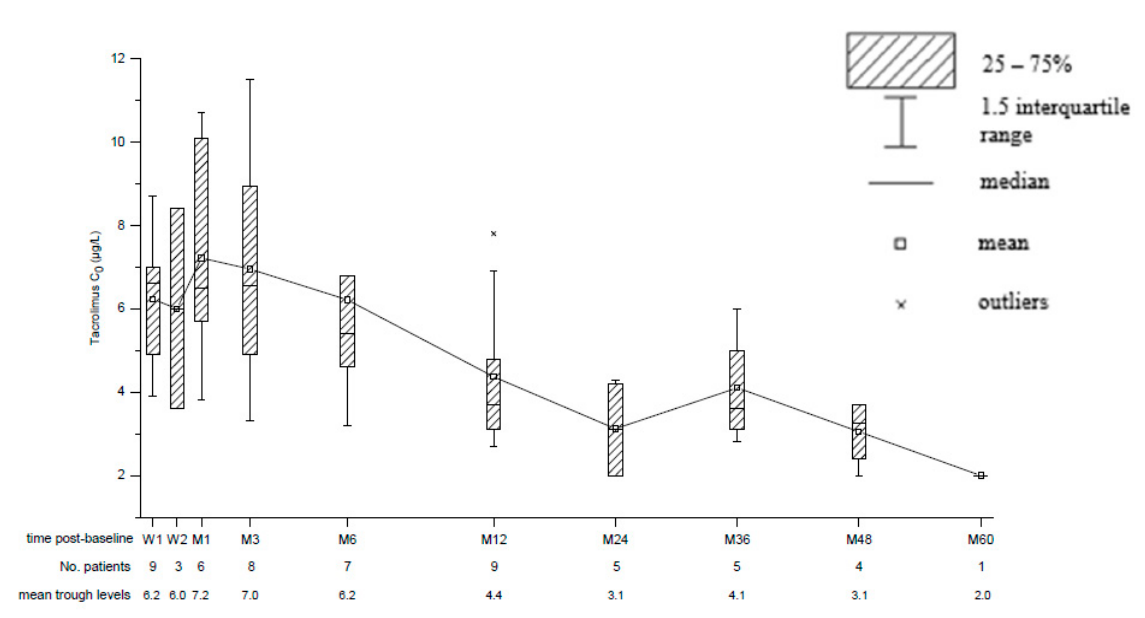
Figure 1. Box and whisker plots for trough concentration (C 0 ) of Everolimus ( I ), Cyclosporin A ( II ) and Tacrolimus ( III ). Time post-baseline is presented in weeks (W) and months (M). The number of patients with available data as well as mean trough levels for each point of interest is displayed below.